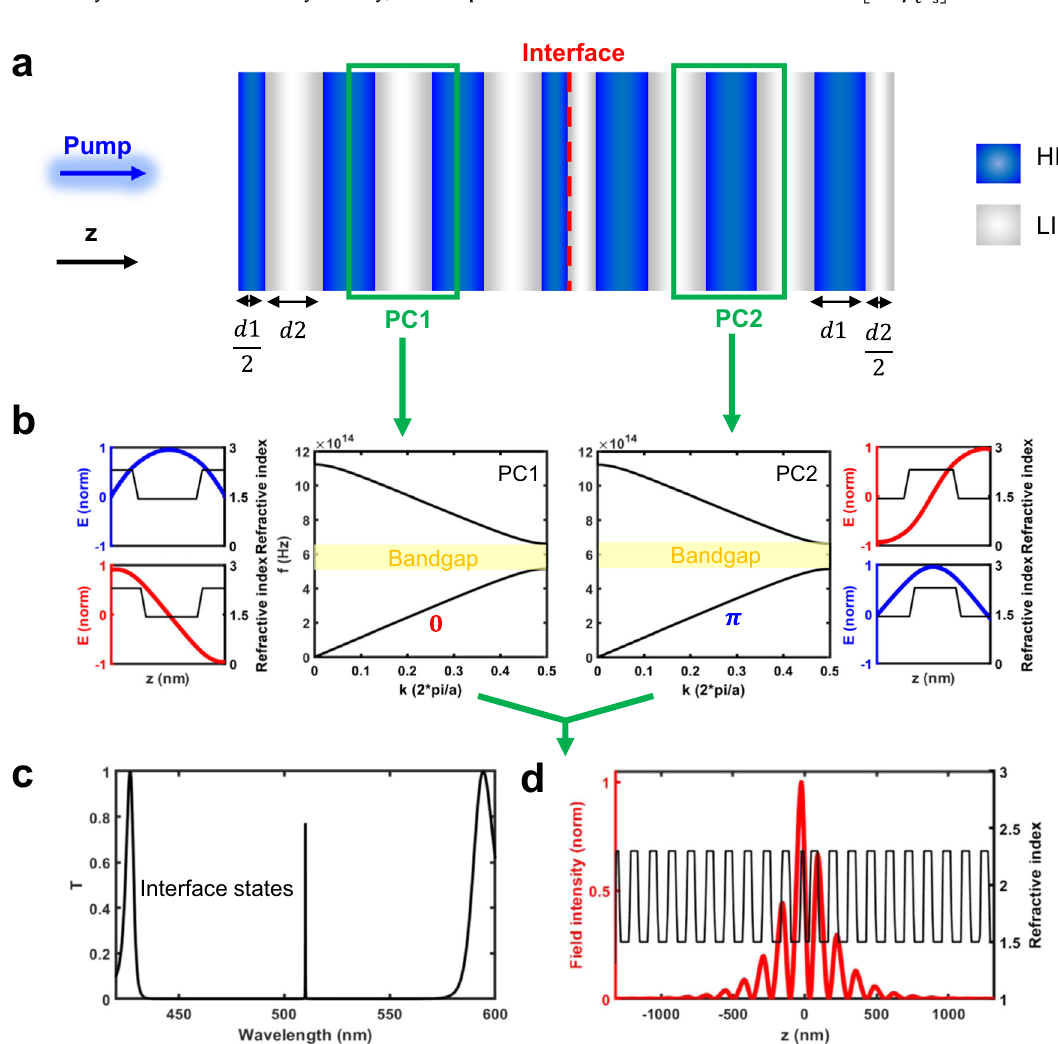
Fig. 1 | Design principles of a 1D topological microcavity. a Schematic of a one- dimensional (1D) topological microcavity formed by interfacing two photonic crystals (PC1 and PC2) composed of alternative high index (HI) and low index (LI) layers. The inversion center of PC1 is chosen to be within the LI layer, while the inversion center of PC2 is within the HI layer, as highlighted by the green boxes. b The calculated optical band structures of PC1 and PC2 are identical but have